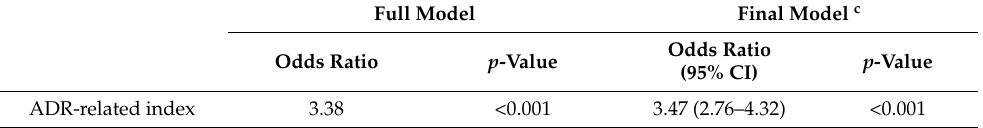
Table 3. Risk factors for a post-index ADR-related admission within 90 days of discharge a,b